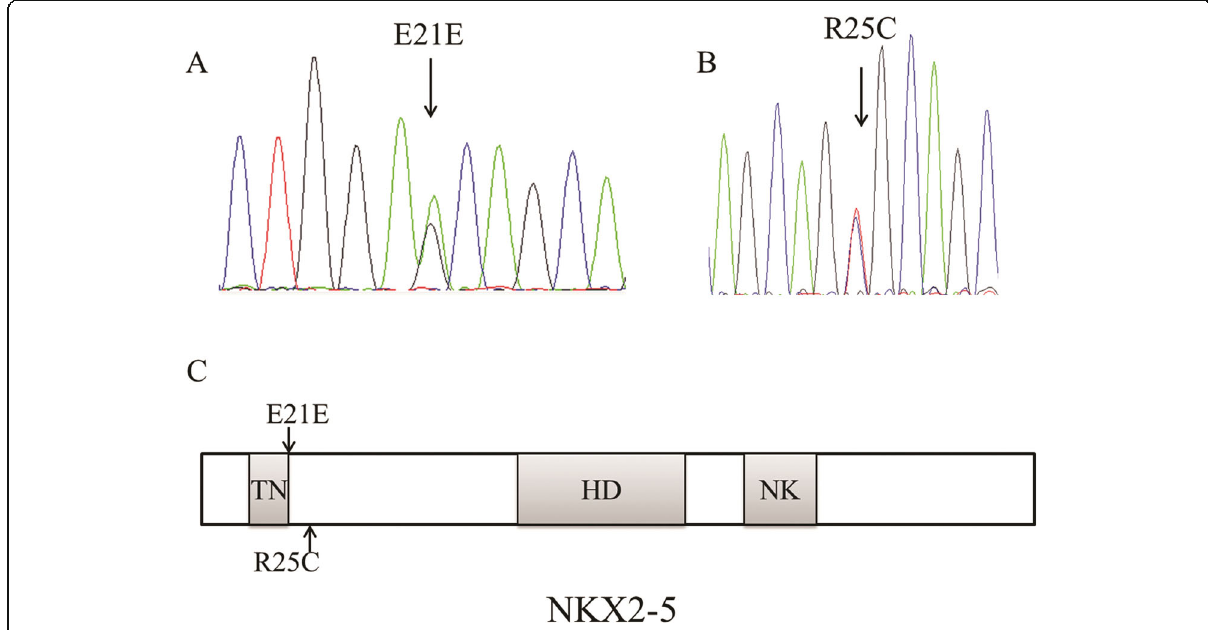
Fig. 1 Sequencing profiles of detected variants ( a , b ) and organization of NKX2.5 domains with detected variants location ( c )